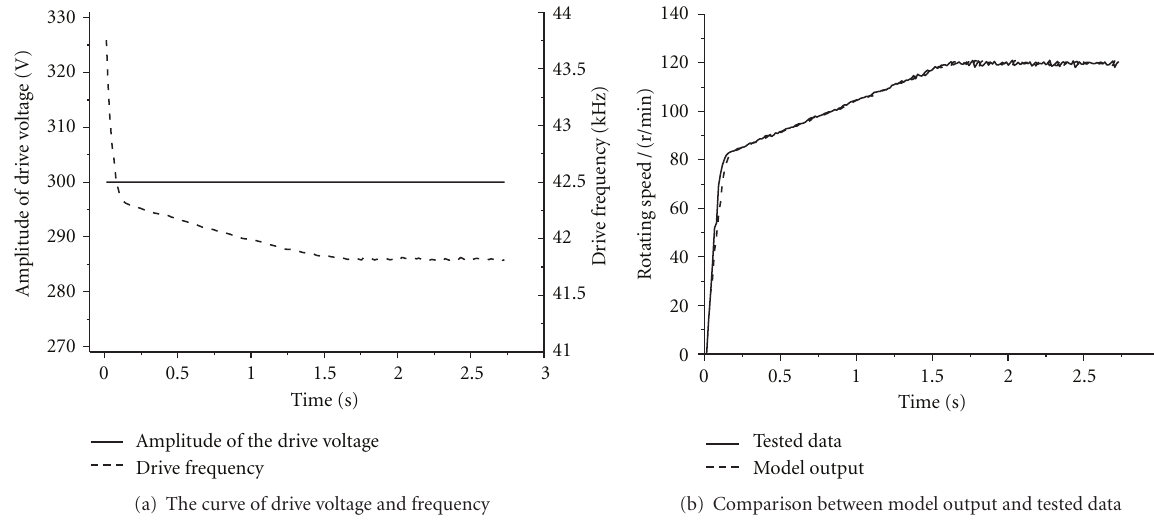
(b) Comparison between model output and tested data Figure 16: Slope response comparison between model output and tested data ( Ure f = 300 V, load torque = 0.2Nm).